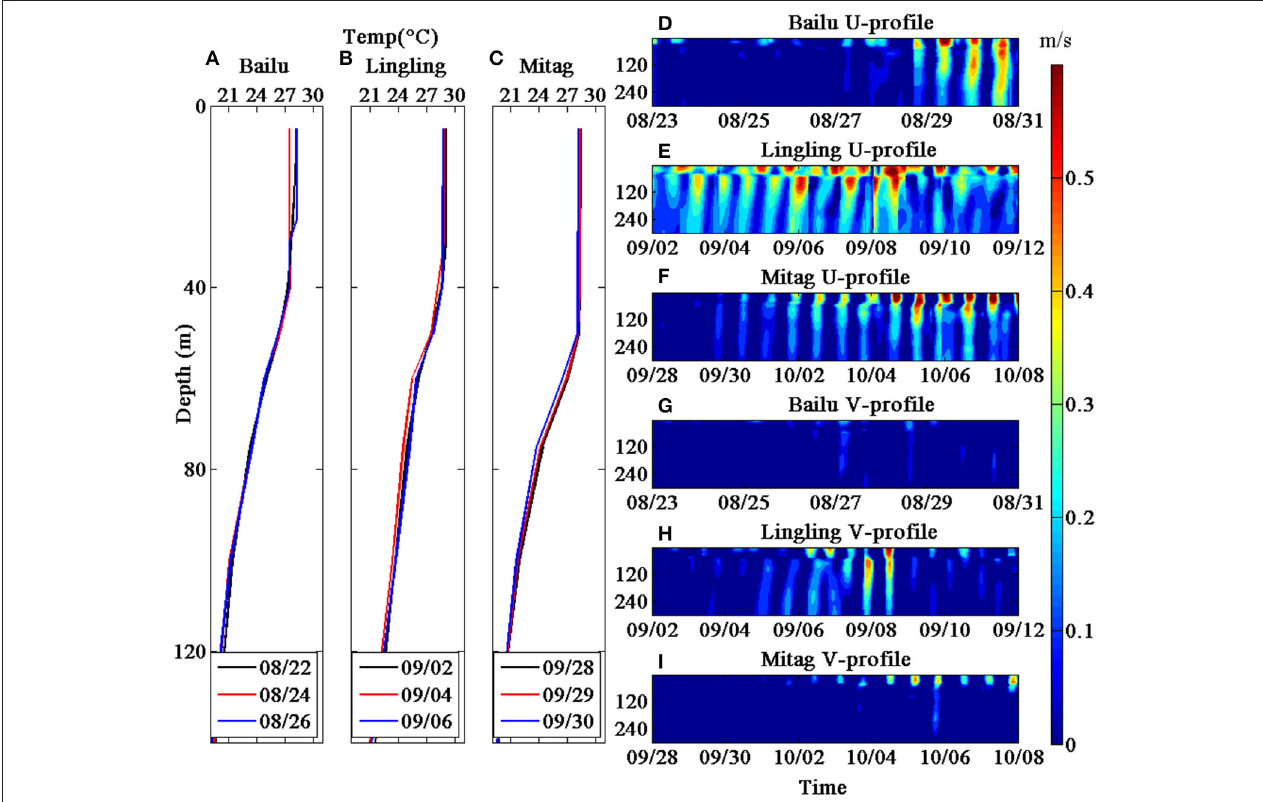
FIGURE 3 | Profiles of temperature for TCs (A) Bailu, (B) Lingling, and (C) Mitag; profiles of eastward velocity during TCs (D) Bailu, (E) Lingling, and (F) Mitag and northward velocity during TCs (G) Bailu, (H) Lingling, and (I) Mitag. Black, red, and blue lines are before, during, and after TCs. The data are from numerical experiment set 1. TCs, tropical